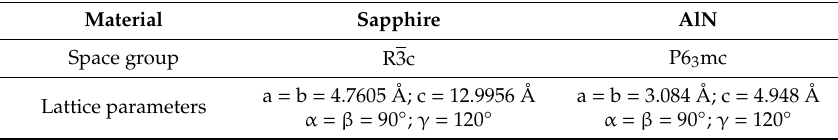
Figure 4. θ -2 θ diagram of a Sc 0.18 Al 0.82 N thin film deposited on a 650 °C heated sapphire substrate, with a plasma pressure of 9 mTorr. The inset figure shows the rocking-curve of the (0002) orientation. Table 4. Space groups and lattice parameters of sapphire and